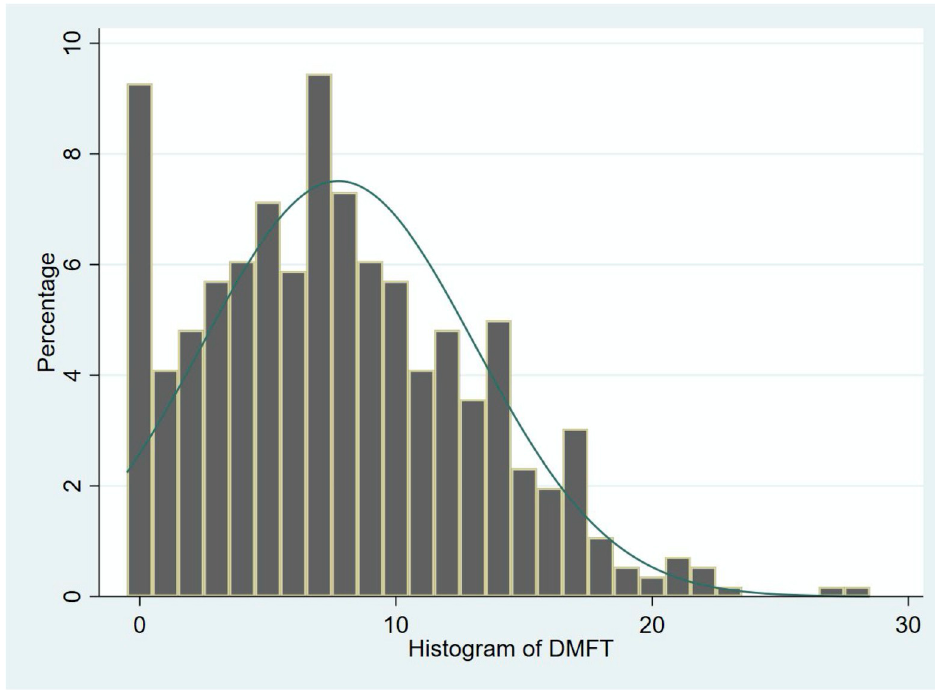
Fig 2. Histogram of DMFT